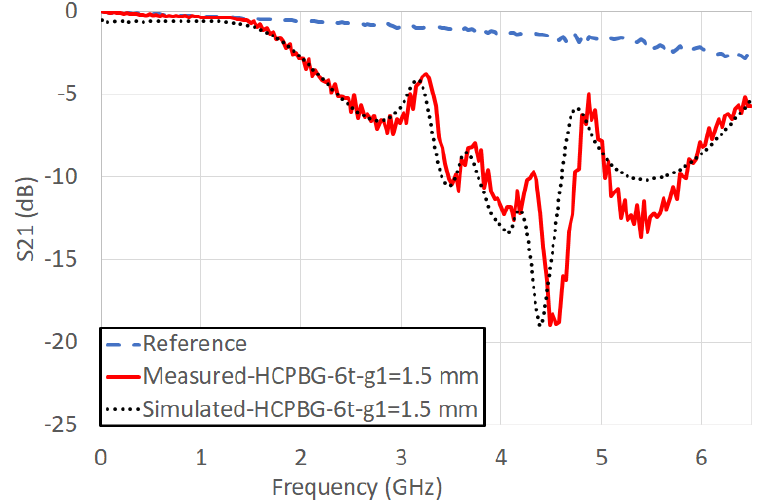
Figure 11. Measurement—transmission loss for HCPBG with 6 traces—gap distances 1.5